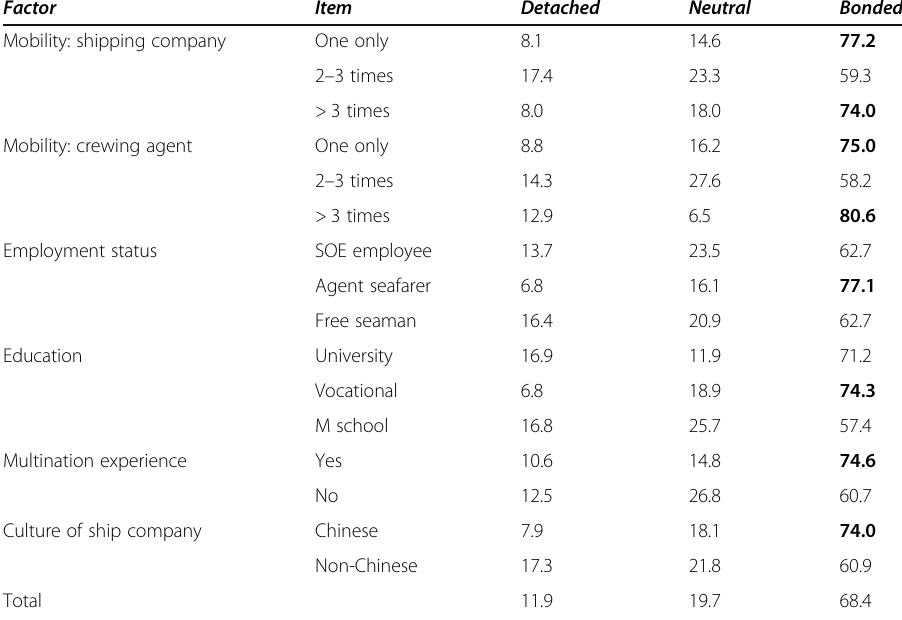
Table 5 Distribution of responses by type of bonding and various factors Factor Item Detached